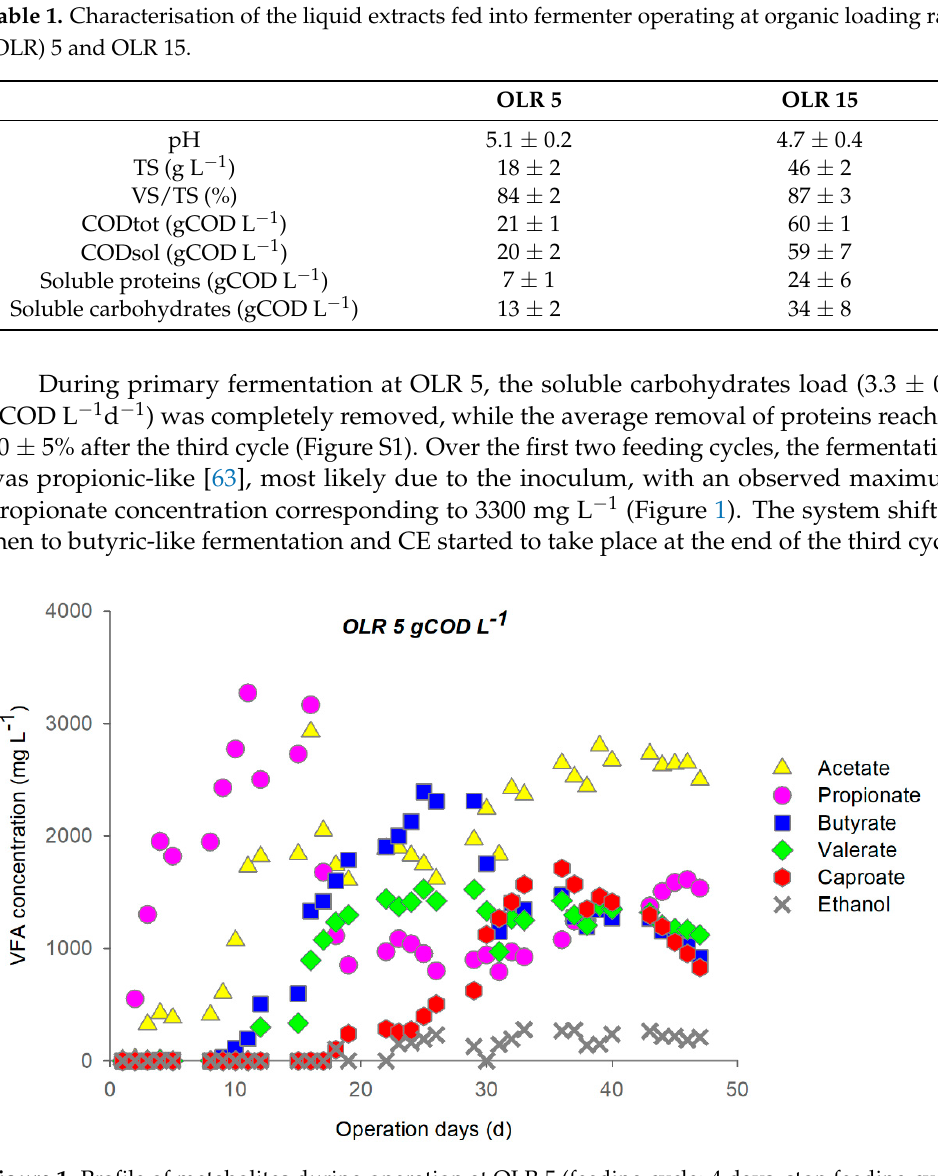
Figure 1. Profile of metabolites during operation at OLR 5 (feeding cycle: 4 days, stop feeding cycle: 3 days).